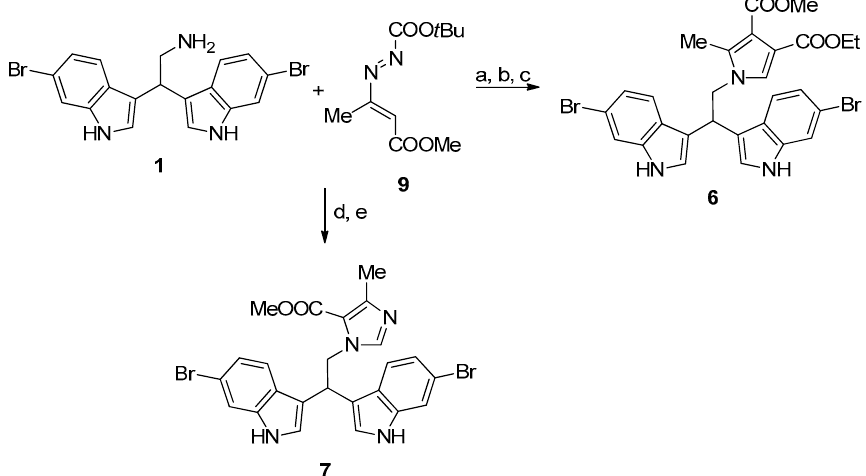
Figure 4. Reaction conditions: ( a ) ethyl propiolate, dichloromethane, at room temperature (RT), overnight (ON); ( b ) 9 , toluene, reflux, 2 h; ( c ) trifluoroacetic acid, reflux, 4 h. ( d ) 9 , acetonitrile, RT, 1 h; and, ( e ) paraformaldehyde, reflux, 4 h.